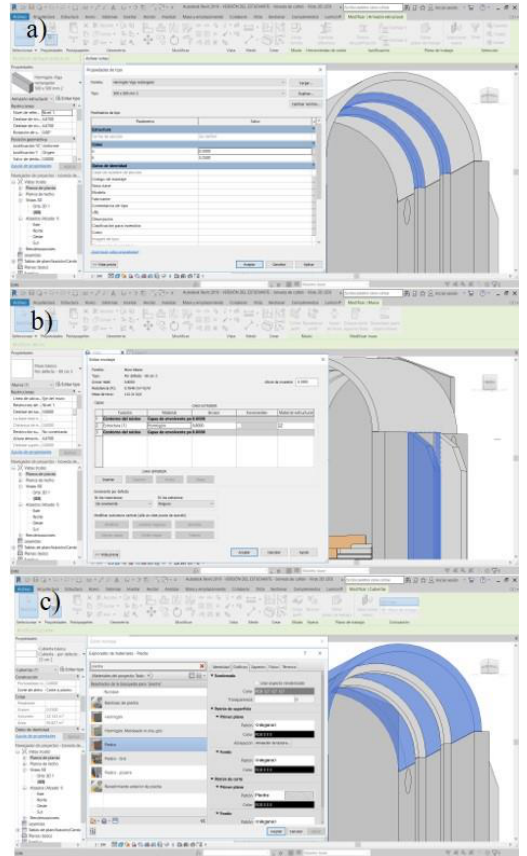
Fig. 8. Metadata. Barrel vault; a) geometric data of the arcs fajones; b) characteristics of the structural elements of the abutments, such as the resistance of the materials; c) characteristics of the materials of the barrel